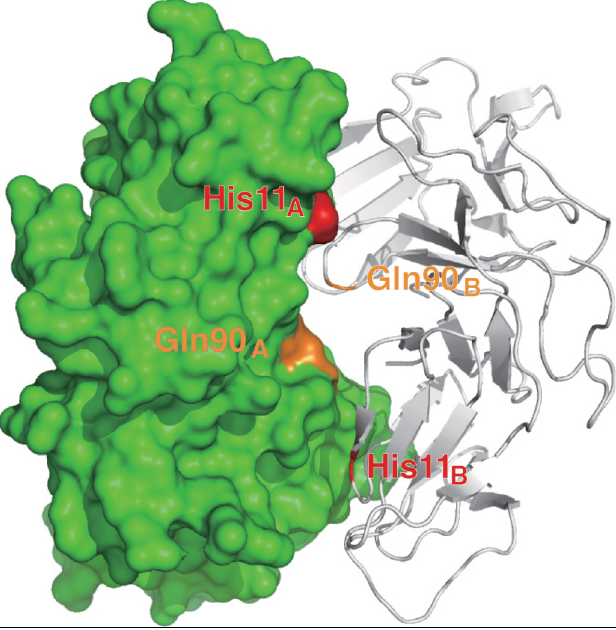
Fig. 2: The dimeric structure of neoculin. One neoculin molecule is de- picted as a green surface with His11 A in red (responsible for pH de- pendent sweetness) and Gln90 A in orange; the other neoculin mono- mer is represented with grey loop and ribbon structure (image taken from o hKuBo at al., 2015; CC BY